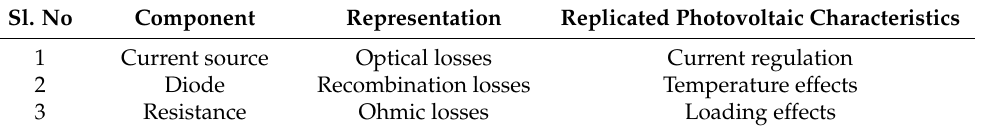
Table 2. Losses in diode modeling.